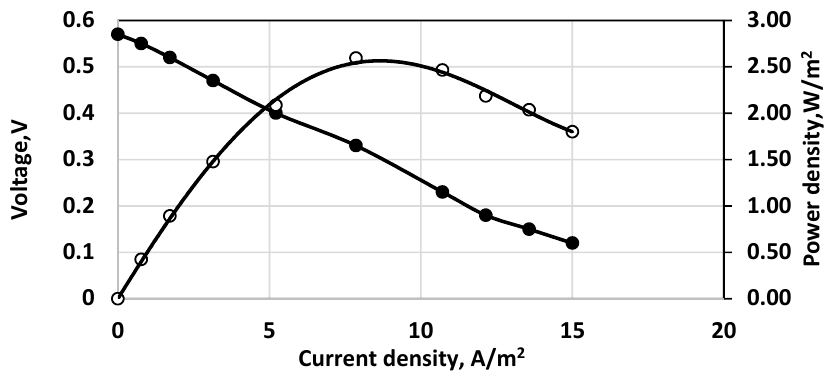
Figure 12. Effect of direct aeration in the cathode space, 6 L/min; 241 mg dm − 3 sulfide solution. Continuous process. Membrane Celgard 3501. Active membrane area—7 sq.cm. Feed flow rate—0.2 dm 3 /h. Anode volume 80 cm 3 . (•)—cell voltage; ( ○ ) power density. Temperature 20 °C.